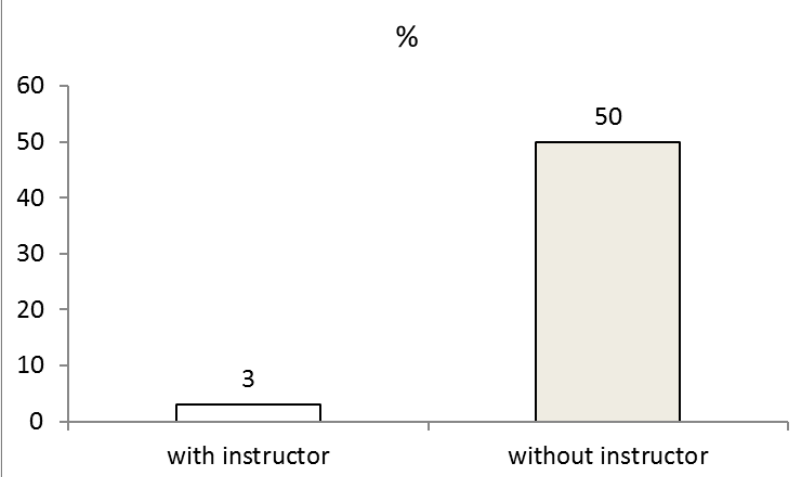
Figure 5. The injury rate depending on how skiing is taught, with instructor or without instructor Table 2. I nvolvement of skiers: ski equipment, wear a helmet? and method of learning Participation of skiers in : Participants People with injuries Percentage of injuries